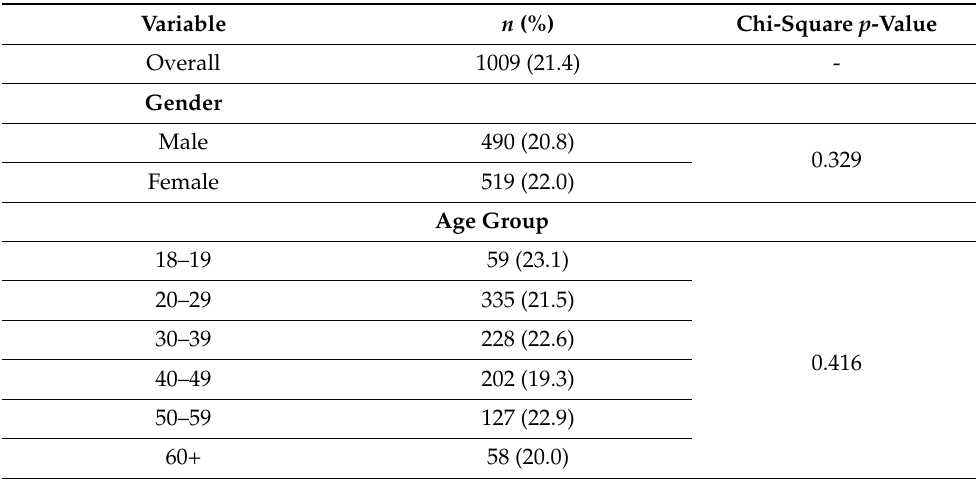
Table 2. Prevalence of self-reported food allergies, overall, and by gender, age group, region, and presence of comorbidity in the study sample ( n =